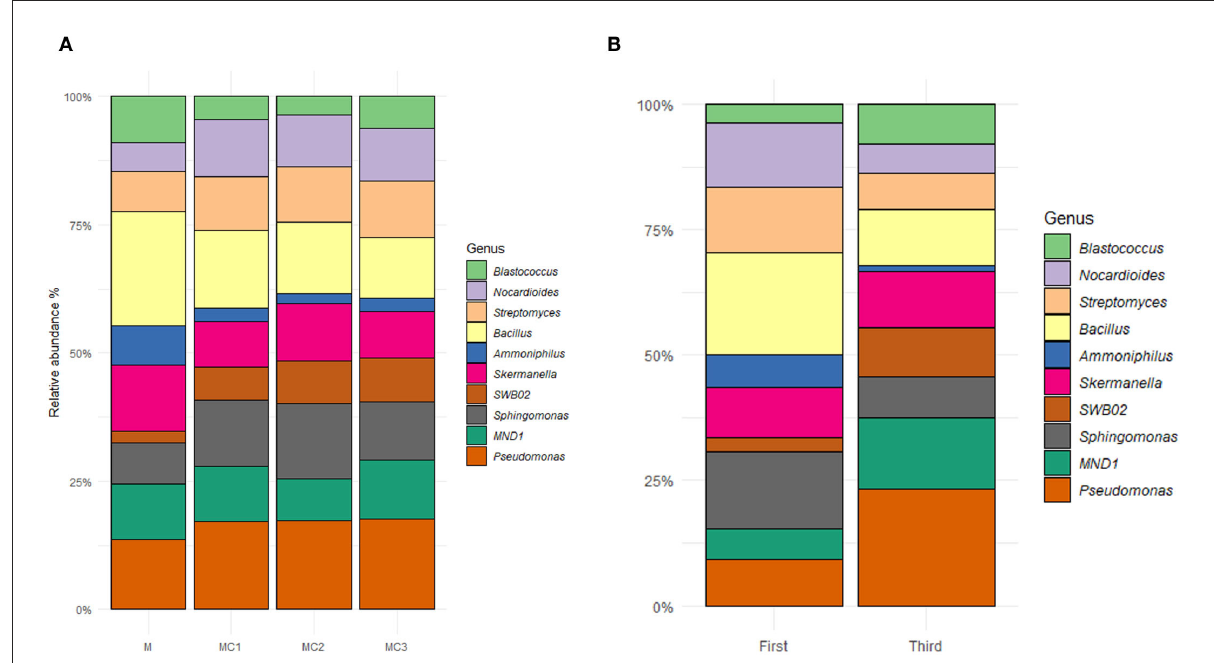
FIGURE4 Top ten more abundant genera in (A) different cropping systems and (B) different sampling times. M, melon monocrop; MC1, mixed intercropping; MC2, intercropping row 1:1 melon:cowpea; MC3, intercropping row 2:1 melon:cowpea; Initial, the first year; final, the last